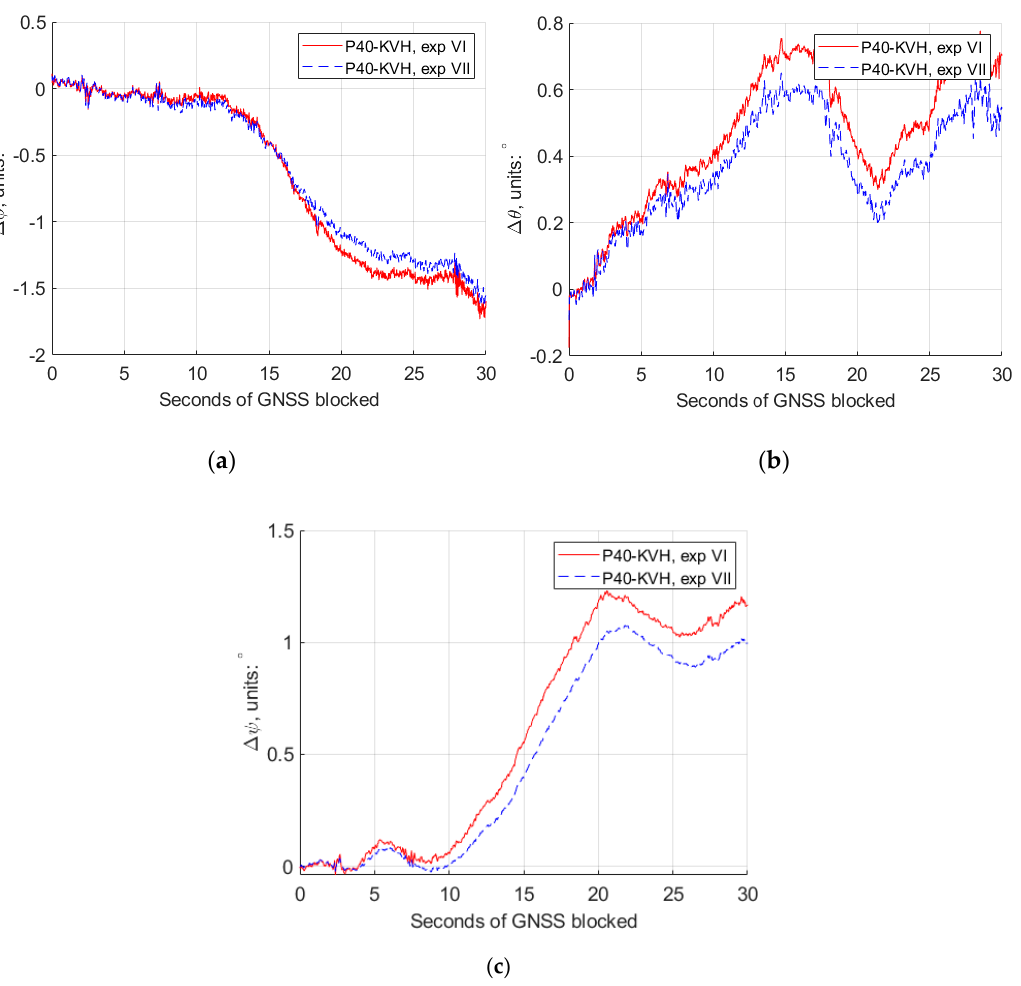
Figure 12. The roll, pitch and yaw attitude differences between GNSS/IMU-P40 (our program in a 15-state Kalman filter) and GNSS/KVH coupled navigation (IE software), with the conventional Kalman filter (experiment VI) and the modified Kalman filter (experiment VII). ( a ) Roll differences; ( b ) pitch differences; ( c ) yaw differences.